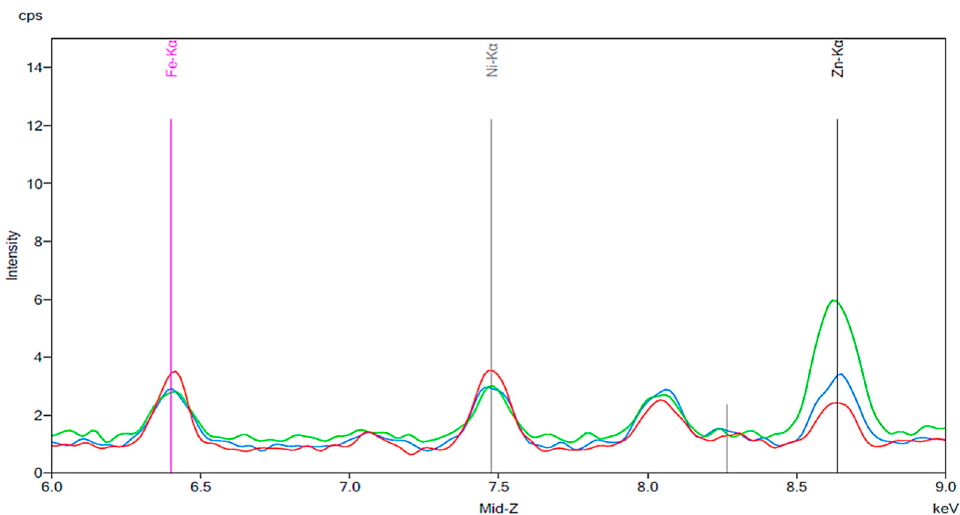
Figure 16. The results of the brushing experiment for artificial teeth exposed to red wine. The red peaks correspond to the new artificial teeth. The green peaks represent the artificial teeth following 24 h exposure to red wine. The blue peaks indicate the red wine exposed teeth following 30 s of brushing.